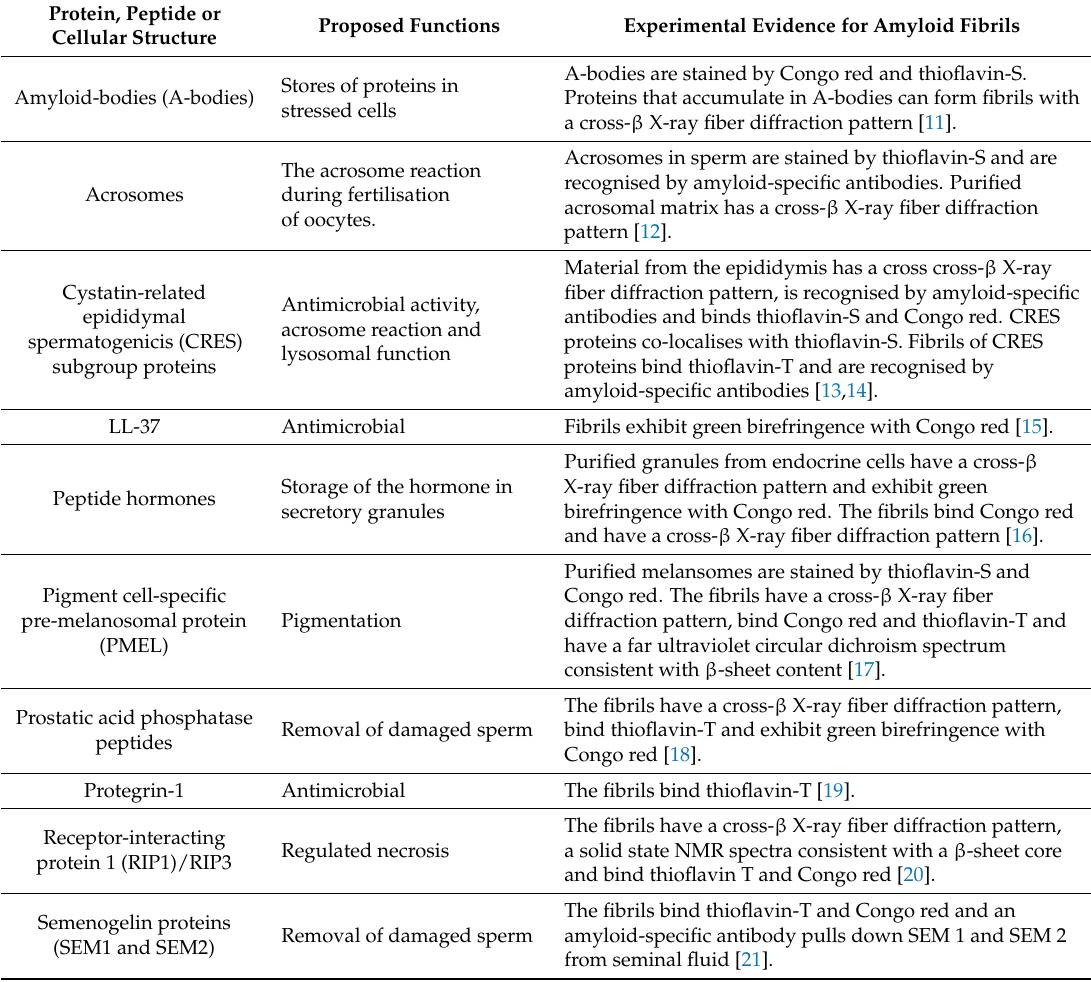
Table 1. Functional amyloids: summary of the experimental evidence for the formation of amyloid